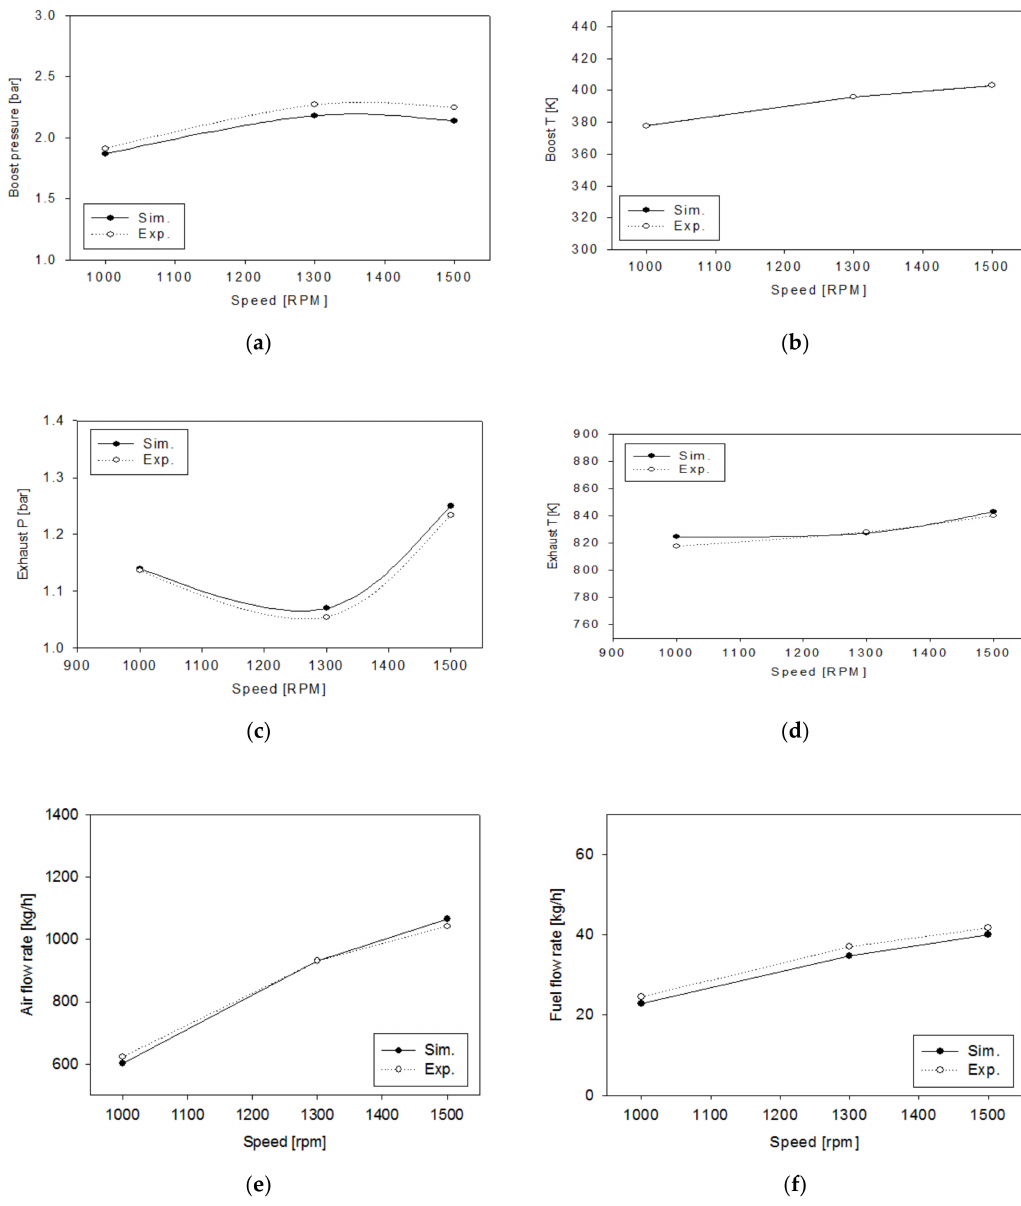
Figure 2. Validation results for thermodynamic and fluidic properties at engine components: ( a ) boost pressure@upstream of intercooler; ( b ) boost temperature@upstream of intercooler; ( c ) exhaust pressure@upstream of turbine; ( d ) exhaust temperature@upstream of turbine; ( e ) air flow rate; ( f ) fuel flow